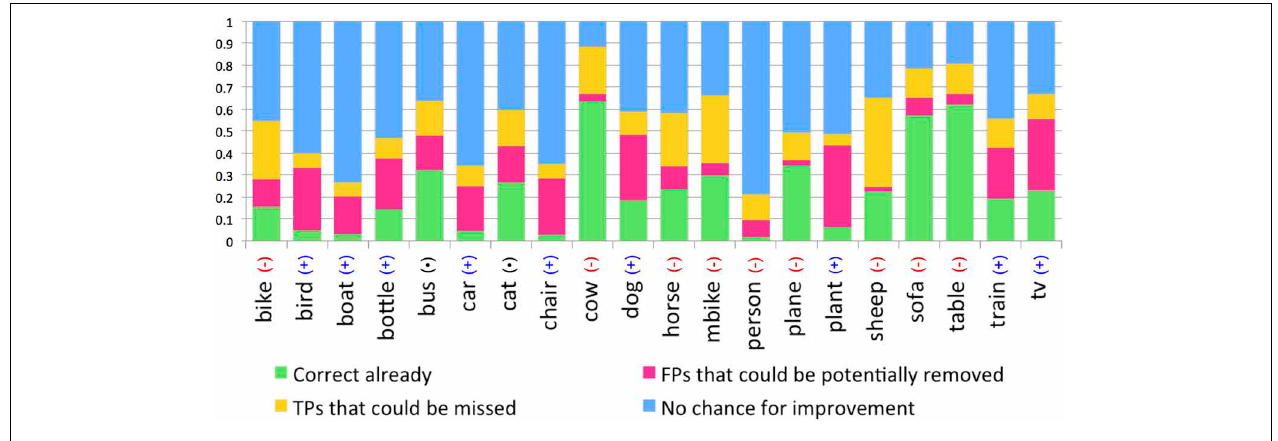
FIGURE 12 | Analyses indicating the potential for gaze to increase (pink), decrease (yellow), or to not affect (green and blue) the performance of object detectors. For categories marked as ( + )